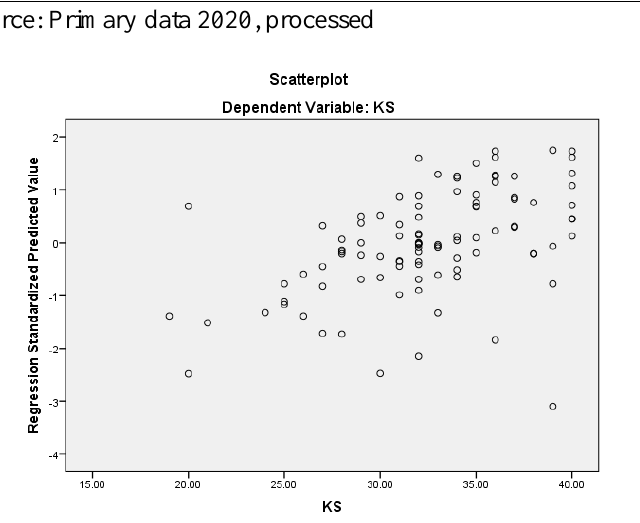
Figure 2. Scatterplot Heteroscedasticity